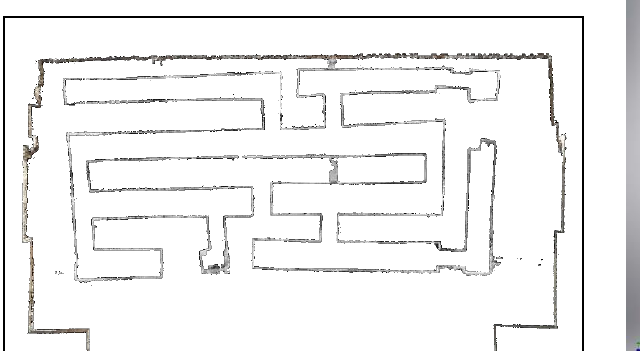
Figure 5. Plan view of Satunsat level 1